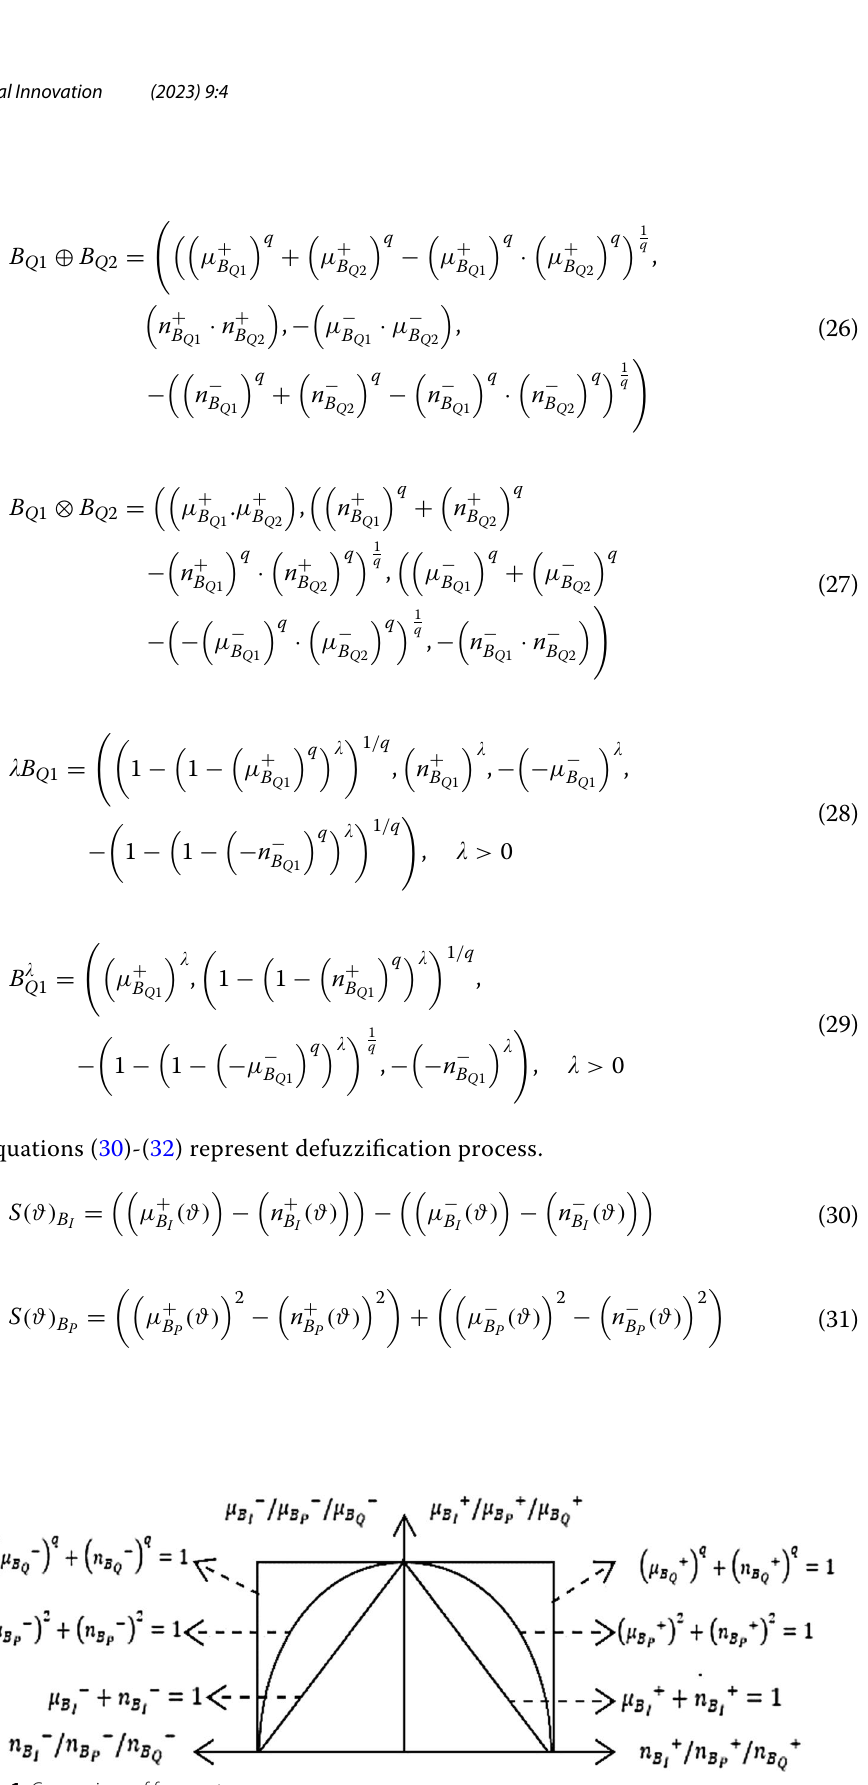
Fig. 1 Comparison of fuzzy